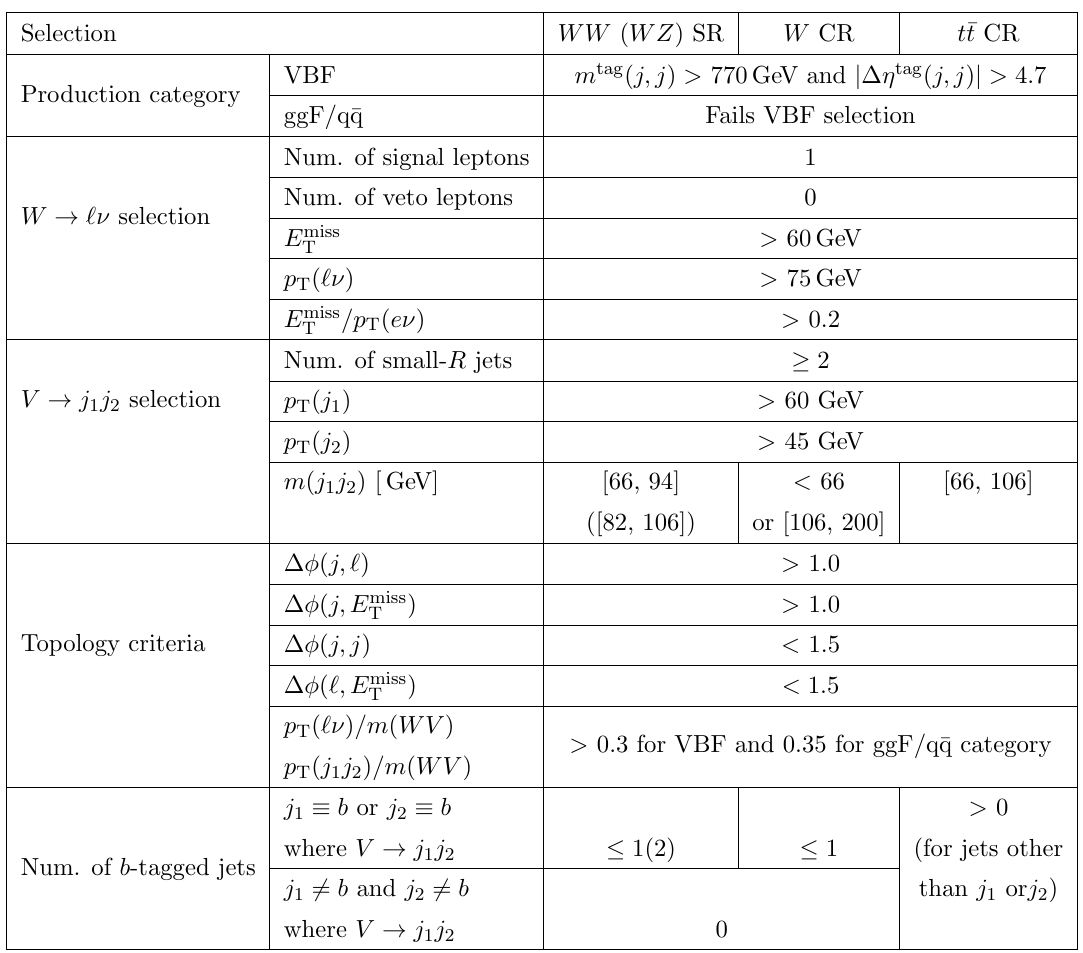
Table 2 . Summary of the selection criteria in the resolved analysis for the WW and WZ signal regions (SR), W +jets control region ( W CR) and t (cid:22) t control region ( t (cid:22) t CR). The events are also categorized according to their production mechanism, the VBF selection is prioritized and the remaining events are assigned to the ggF = q(cid:22)q